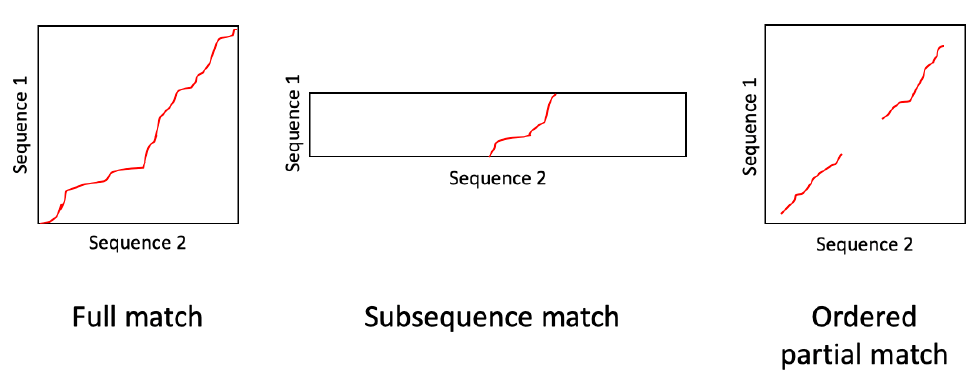
Figure 1. Different types of alignment problems. HSTW provides a parameter-free solution to the ordered partial match alignment